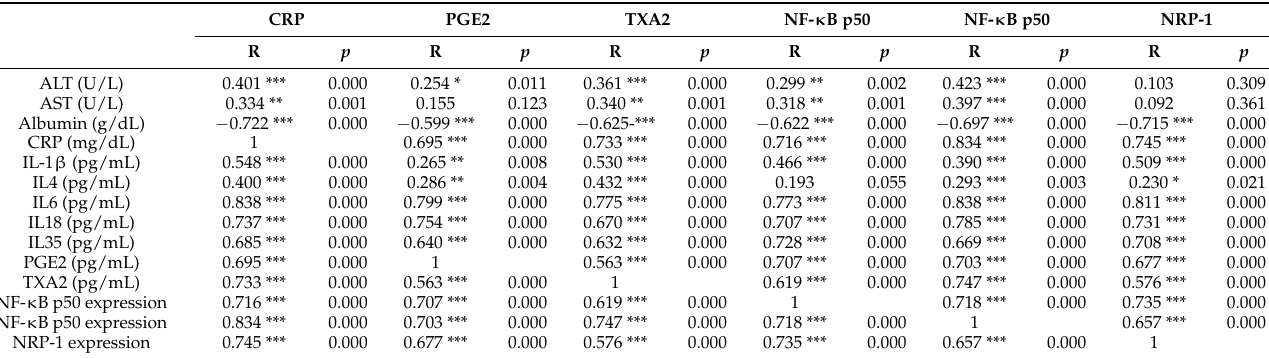
Table 4. Correlation between CRP, PGE2, TXA2, NF- κ B p50, NF- κ B p65 and NRP-1 with all parame- ters in the severe